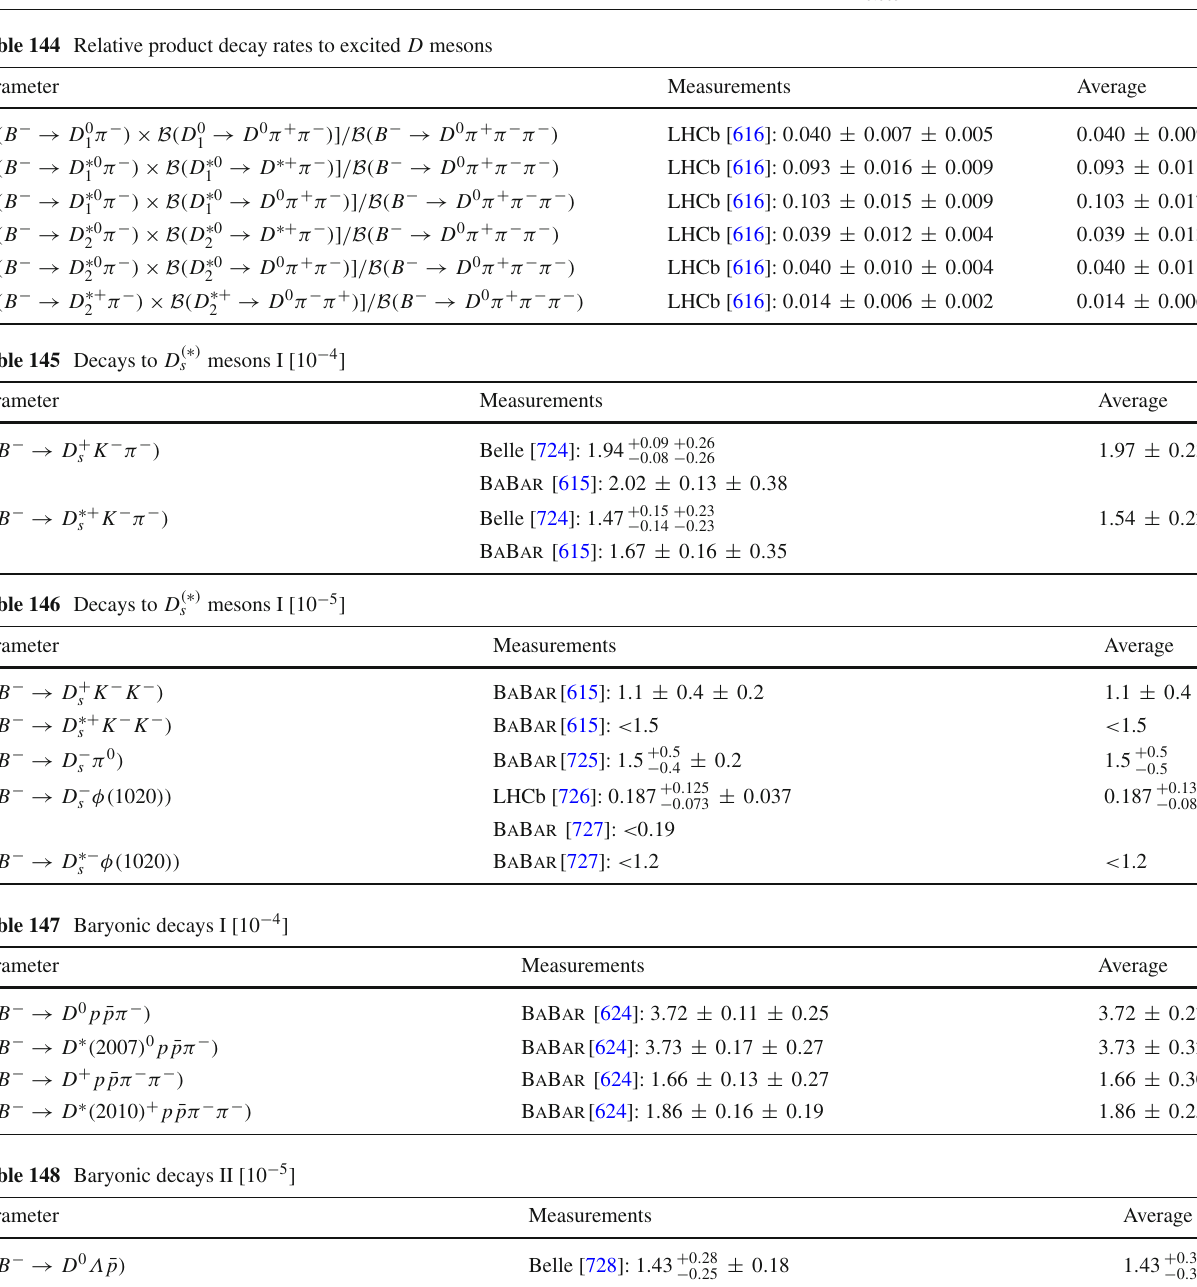
Table 144 Relative product decay rates to excited D mesons Parameter